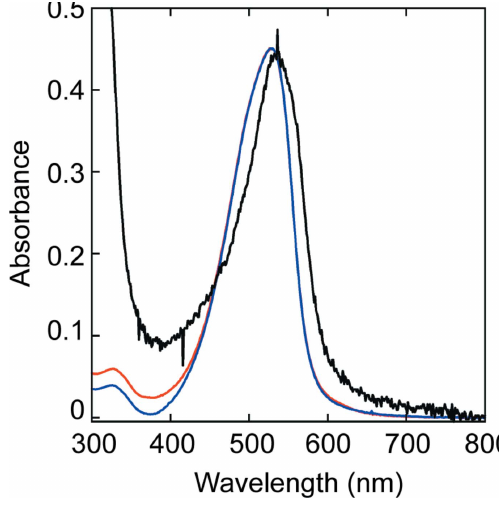
Figure 5 UV–vis spectra of 2HP-inhibited LOXL2 (LOXL2–2HP) (in black) (Meier, Moon et al. , 2022), crystalline 3 isolated from a 1:1 mixture of 2 with CuCl 2 (phen) (in blue), and crystalline 3 isolated from a 1:1 mixture of 2 with CuCl 2 (in red). All spectra were recorded in 50 m M HEPBS buffer (pH